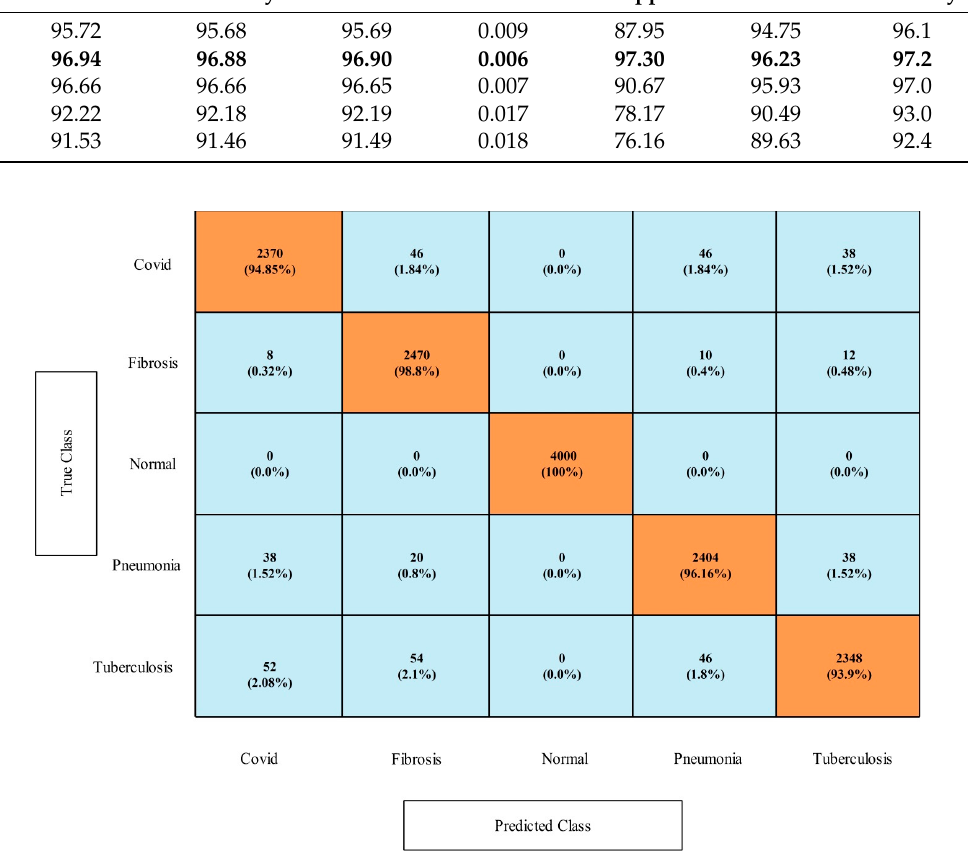
Figure 12. Proposed improved CCA fusion method confusion matrix of MNN on COVID-19 Image dataset.